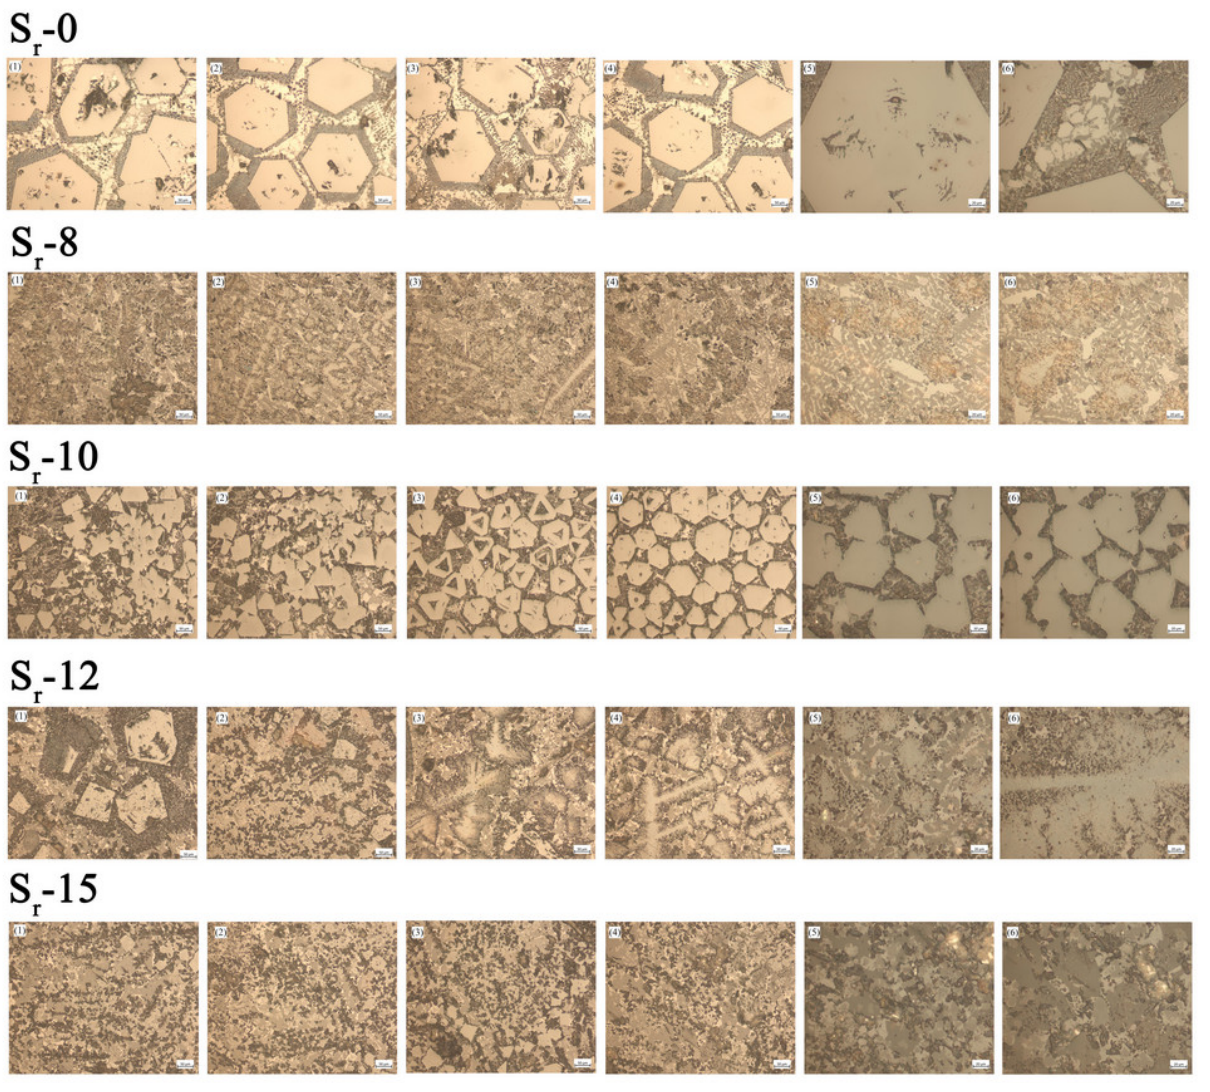
Figure 6. Mineralogram of blast furnace slag tempered slag roasting specimen. (1) to (4) are 300 × magnified mineral phases, (5) and (6) are 500 × magnified mineral